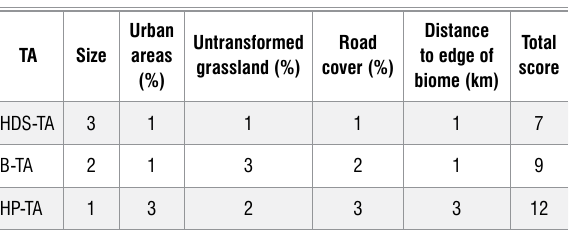
The scoring system applied to determine the most suitable target area for conservation in the Grassland Biome of South